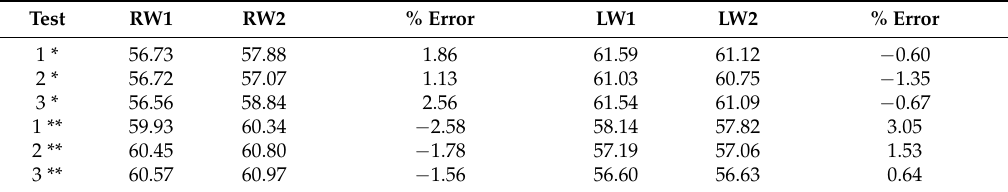
Table 4. Half court lap distance tracking results, comparing the IMU derived output with the known court markings. (Note: * denotes clockwise travel. ** denotes anticlockwise travel. Perimeter of the court 14 m × 15 m, Wheelbase = 0.87 m, therefore the internal wheel should travel 56.26 m and the external should travel 61.73 m).